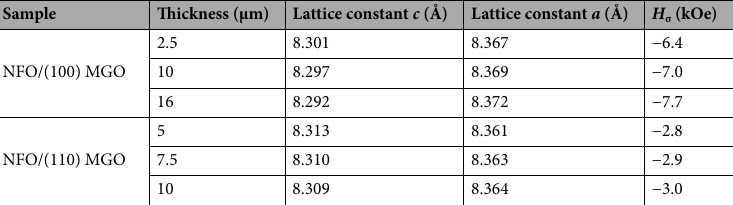
Table 2. Out of plane lattice constant c determined from XRD data, estimated in-plane lattice constant a, and the strain induced anisotropy field H σ .